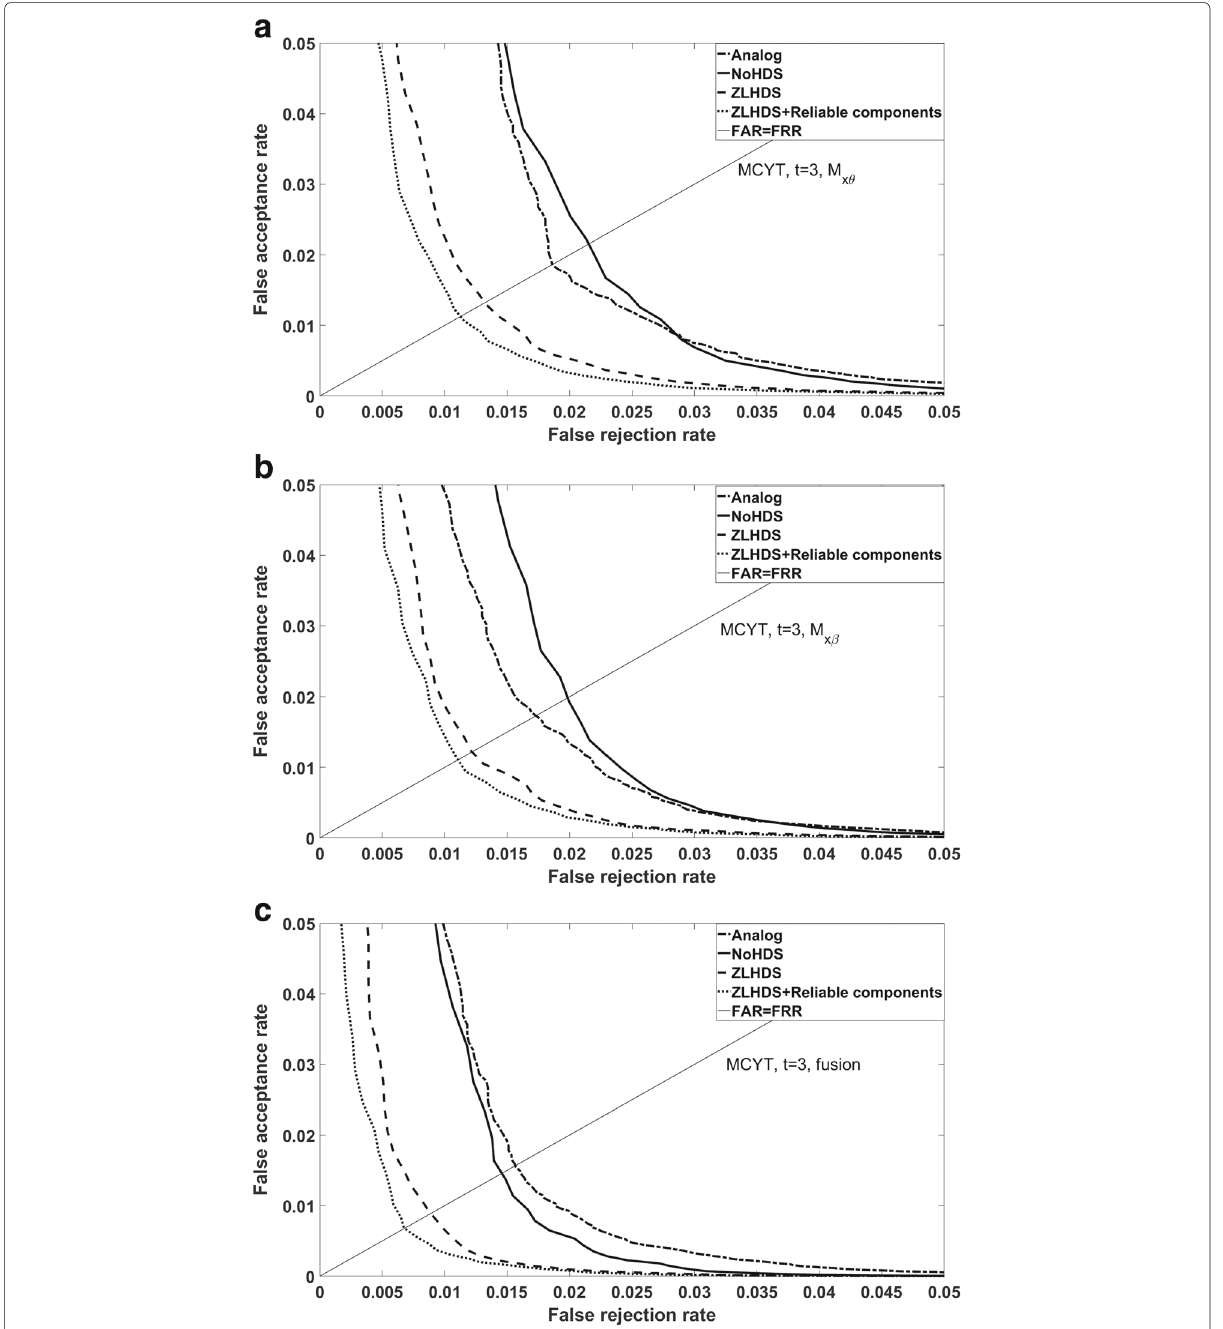
Fig. 10 Performance result for several processing methods. MCYT. Enrollment method E2 with t = 3